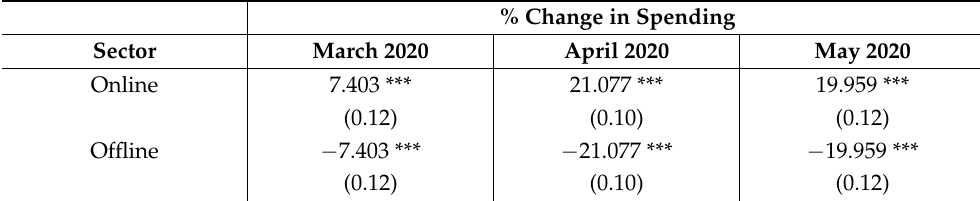
Table 3. Estimated Changes in Spending across Shopping Channels.